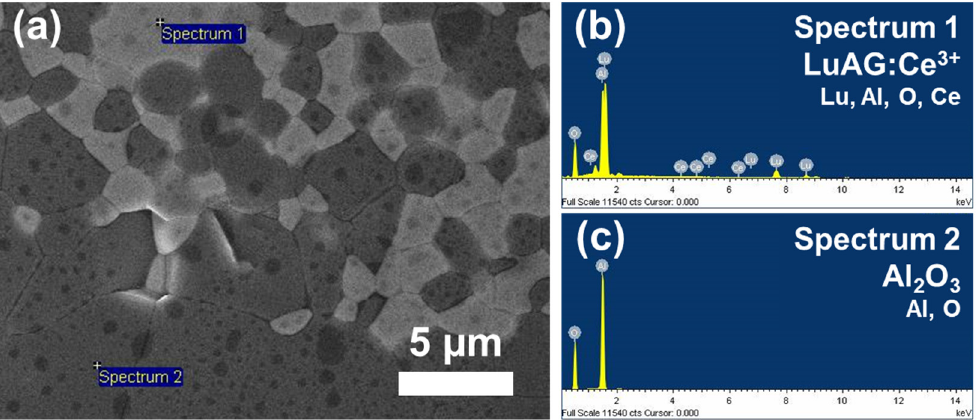
Figure 3. ( a ) Cross ‐ sectional SEM image of the prepared ceramic phosphor; ( b ) and ( c ): point EDS spectra of LuAG:Ce 3+ and Al 2 O 3 ,